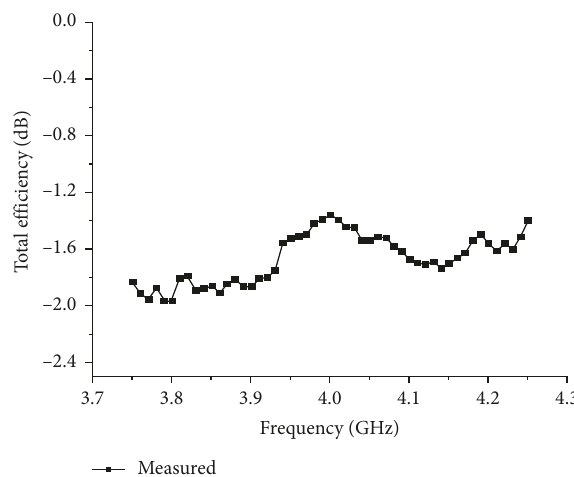
Figure 12: Measured total efficiency in free-space of the reflector-backed